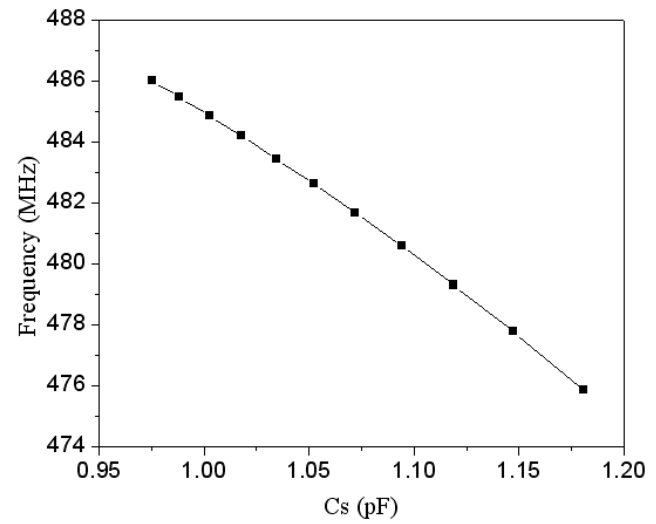
Figure 4. Oscillation frequency of the ring oscillator.